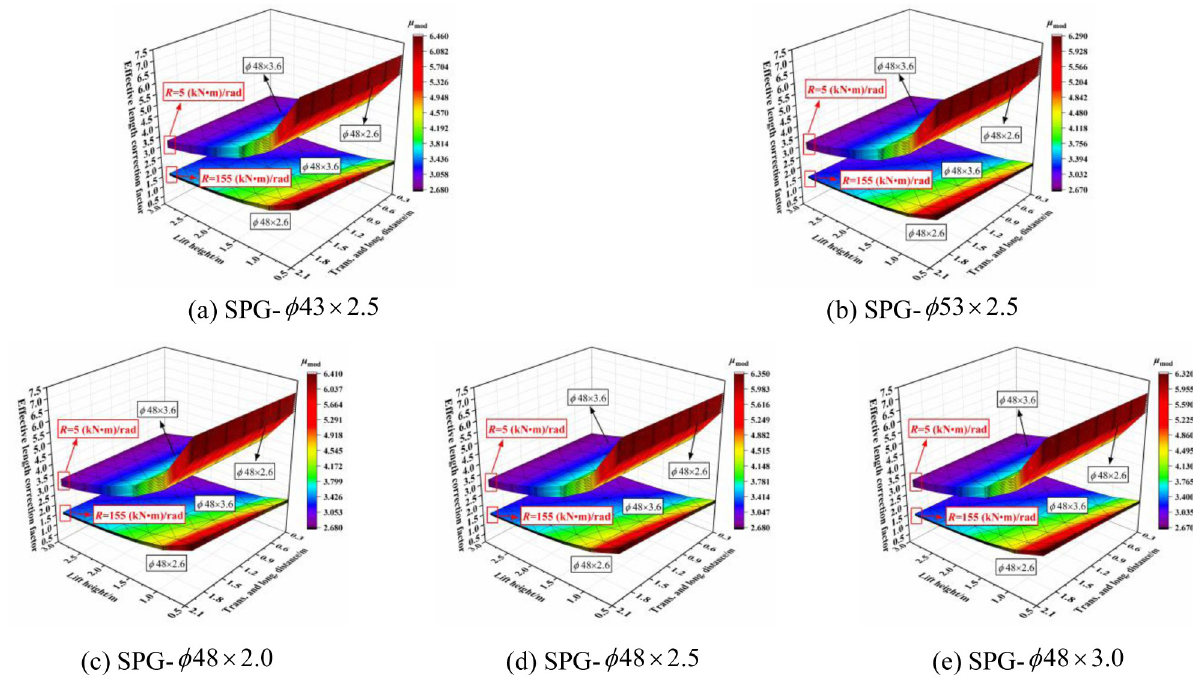
Fig 25. Three-dimensional diagrams of the influence of wall thickness size of vertical pole section on the effective length correction factor. (a) SPG- ϕ 43 × 2.5. (b) SPG- ϕ 53 × 2.5. (c) SPG- ϕ 48 × 2.0. (d) SPG- ϕ 48 × 2.5. (e) SPG- ϕ 48 × 3.0.